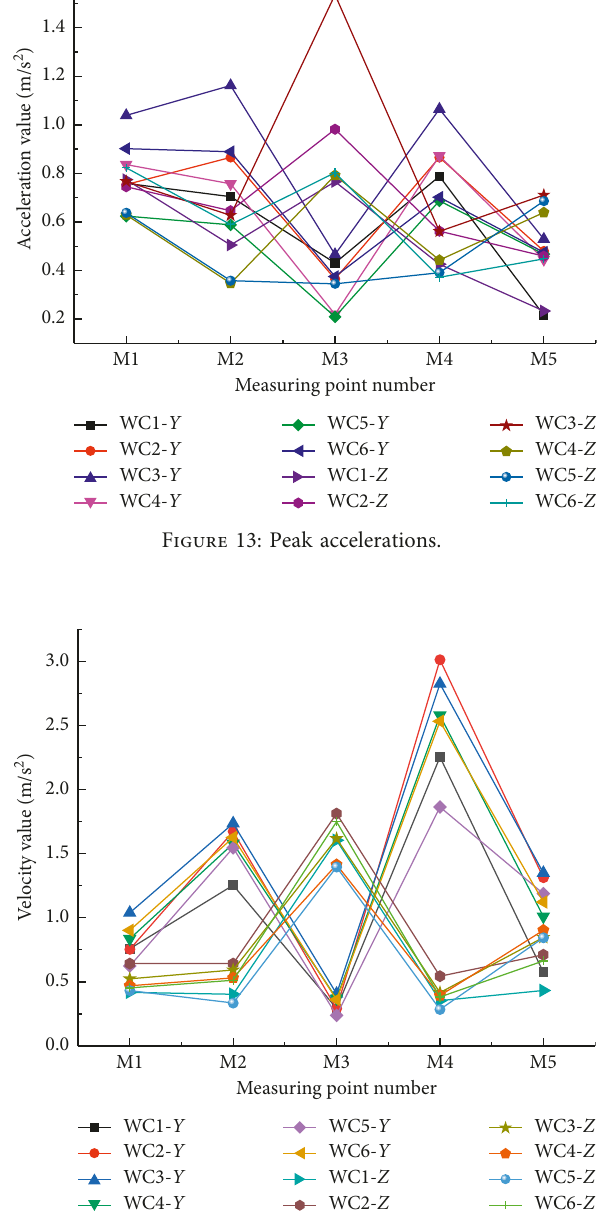
Figure 14: Peak velocities at measuring point 5.